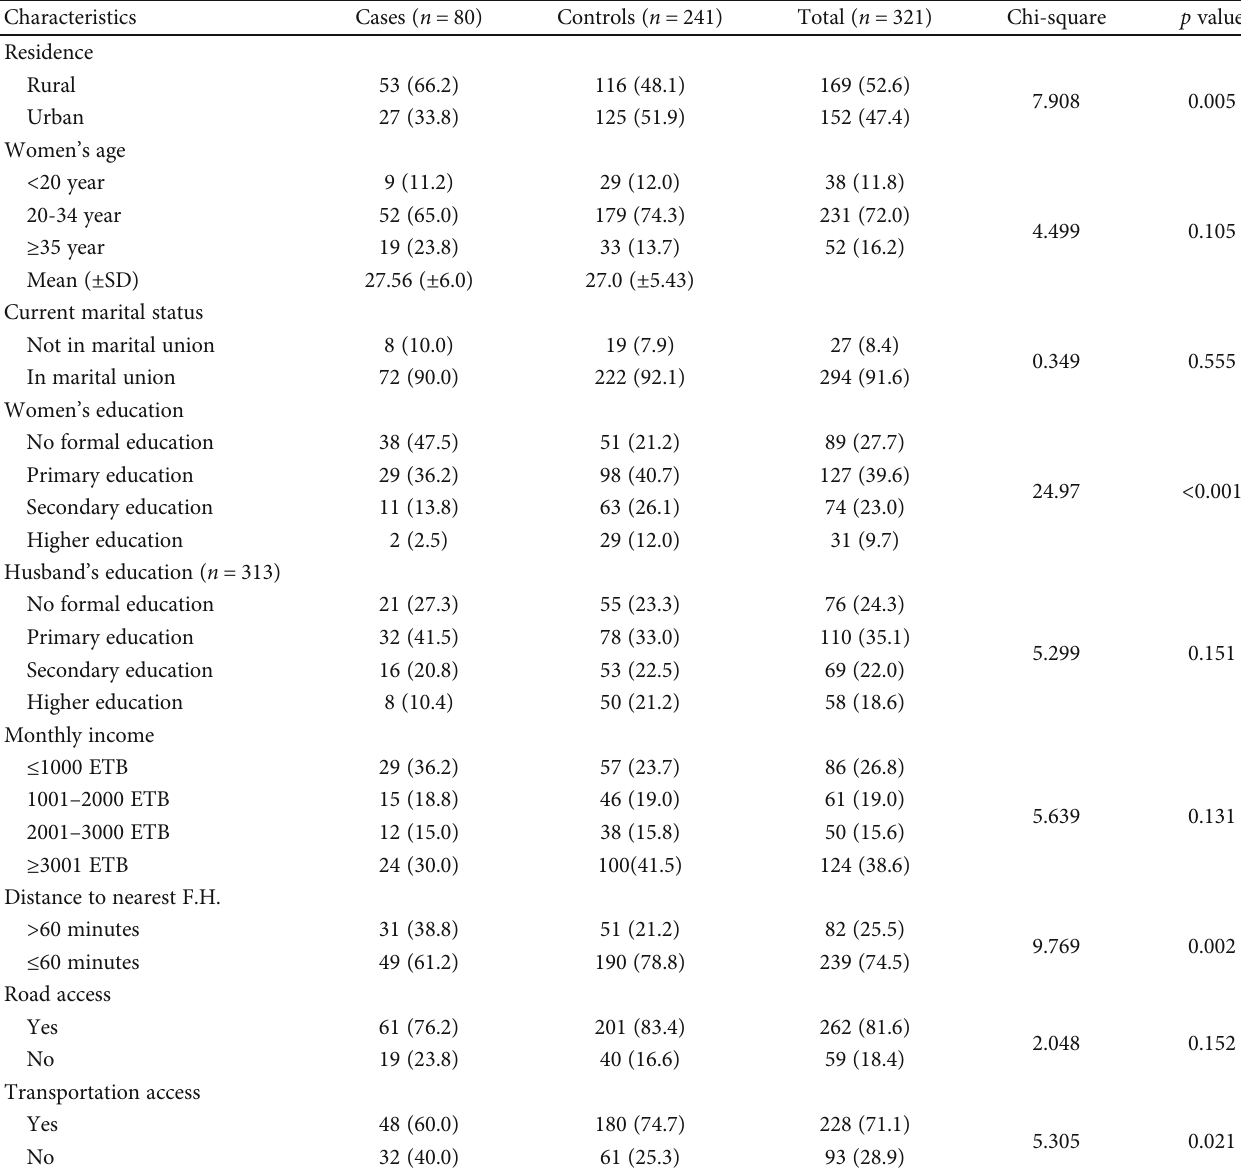
Table 1: Sociodemographic and economic characteristics of women admitted in Western Arsi zone public hospitals, Ethiopia, 2020.